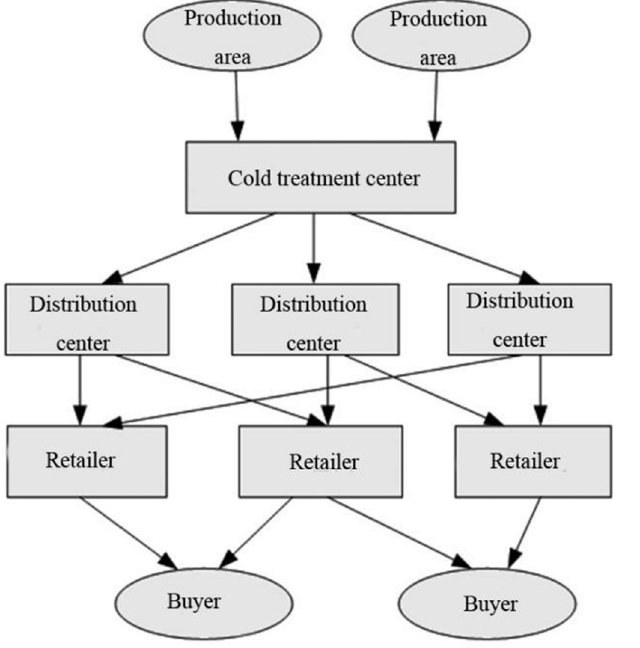
Fig. 1. Schematic diagram of cold chain logistics transportation.